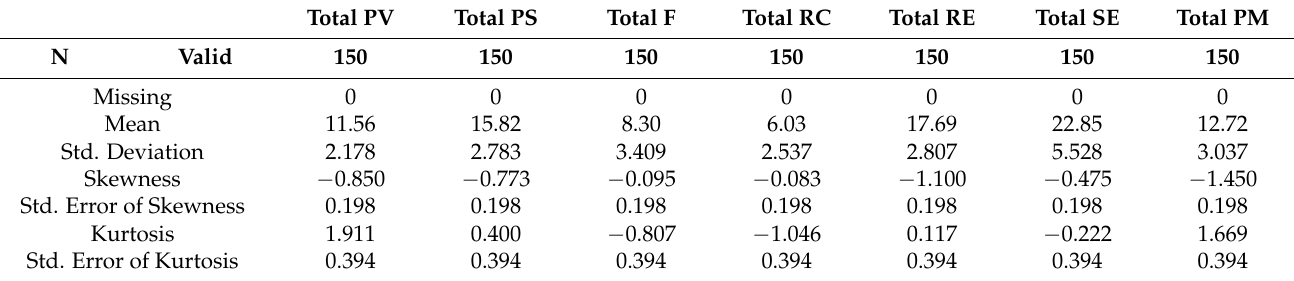
Table 3. The description of the PMT scale